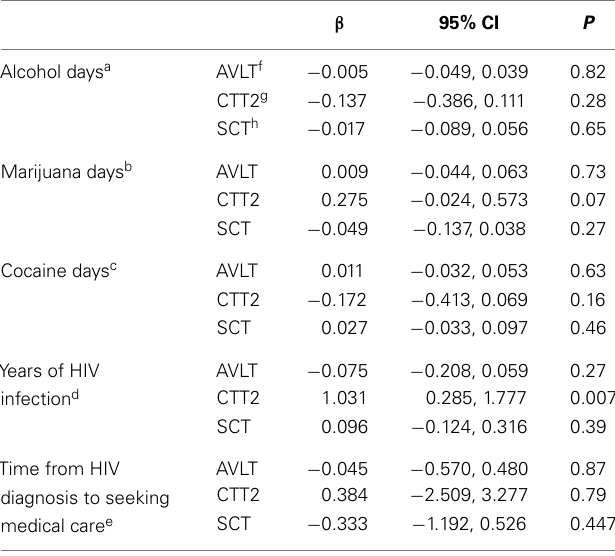
Table 2 | Bivariate regression statistics, 95% confidence intervals, and p -values ( N = 370)